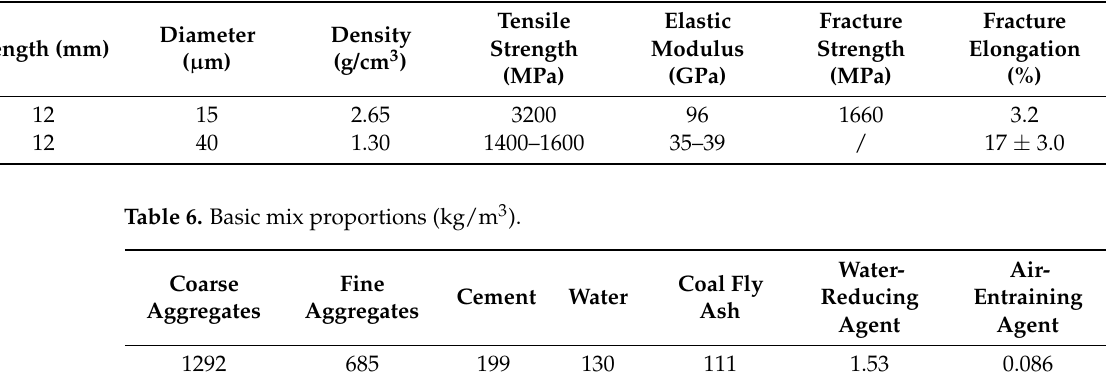
Figure 1. Appearance and length of BF and PVAF. ( a ) BF and ( b ) PVAF. Table 5. Performance indicators of BF and PVAF.